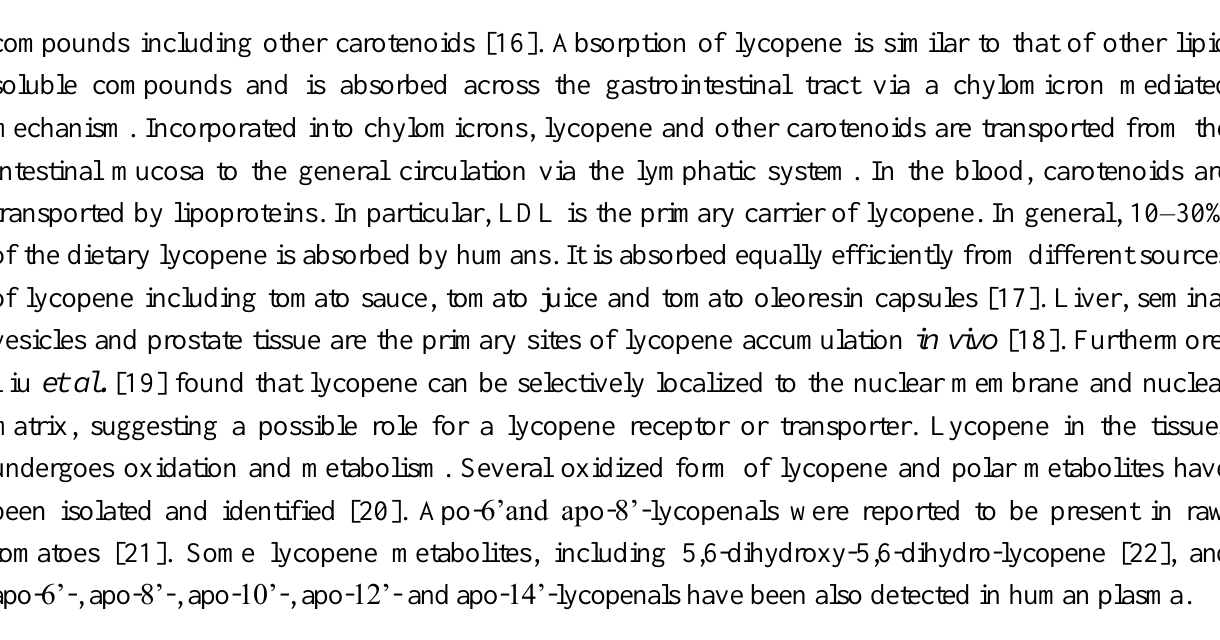
Figure 1. Chemical structure of